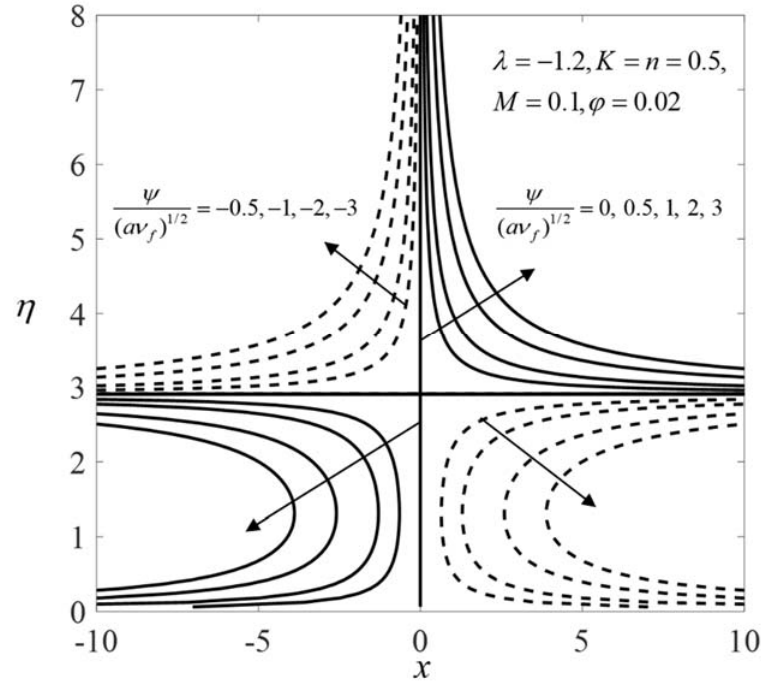
Figure 13. Streamlines when λ < 0 (shrinking sheet) for the first solution.